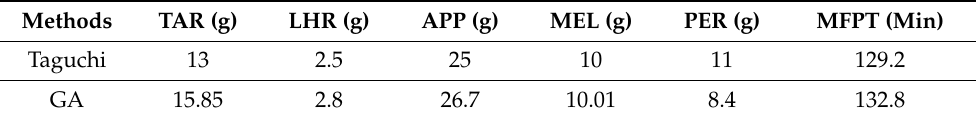
Table 4. A comparison between Taguchi and the genetic algorithm (GA) methods in terms of